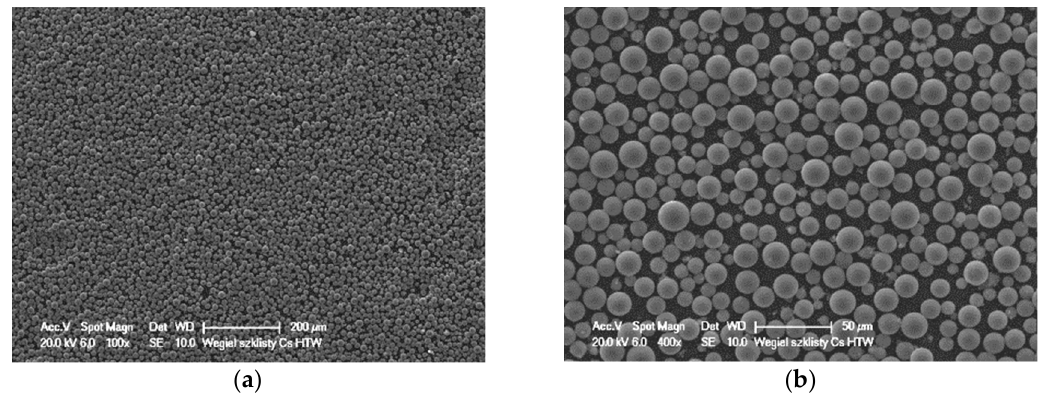
Figure 3. SEM images showing the morphology of spherical glassy carbon particles (GC sf ).